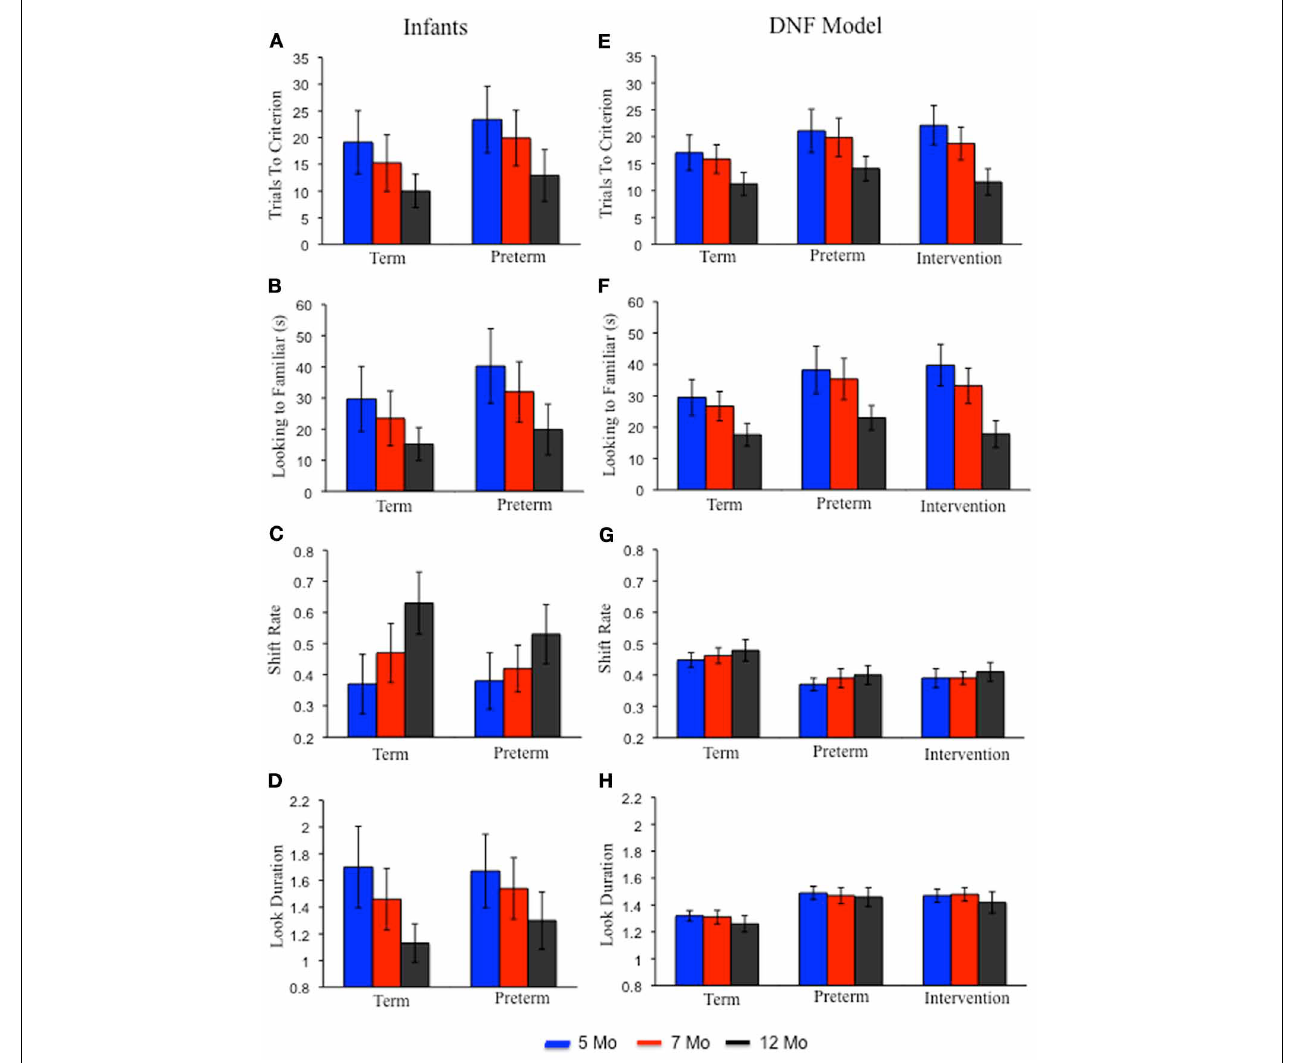
FIGURE 4 | Panels (A–D) show empirical results from the processing speed task reported by Rose et al. (2002) for term (left) and preterm (right) infants at 5 (blue), 7 (red), and 12 (black) months of age. With age, term and preterm infants exhibited fewer trials to criterion (A) , accumulated less time looking to the familiar (B) , higher shift rates (C) , and shorter look durations (D) . Preterm infants’ behavior at every age